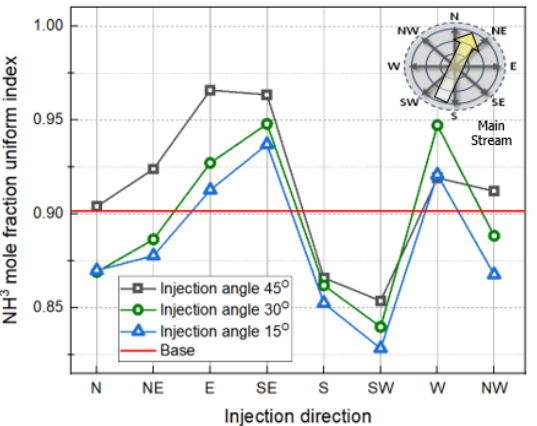
Figure 12. Ammonia uniformity index (UI) according to the various injection angle and direction candidates at the 400 mm distance from the urea injection point.